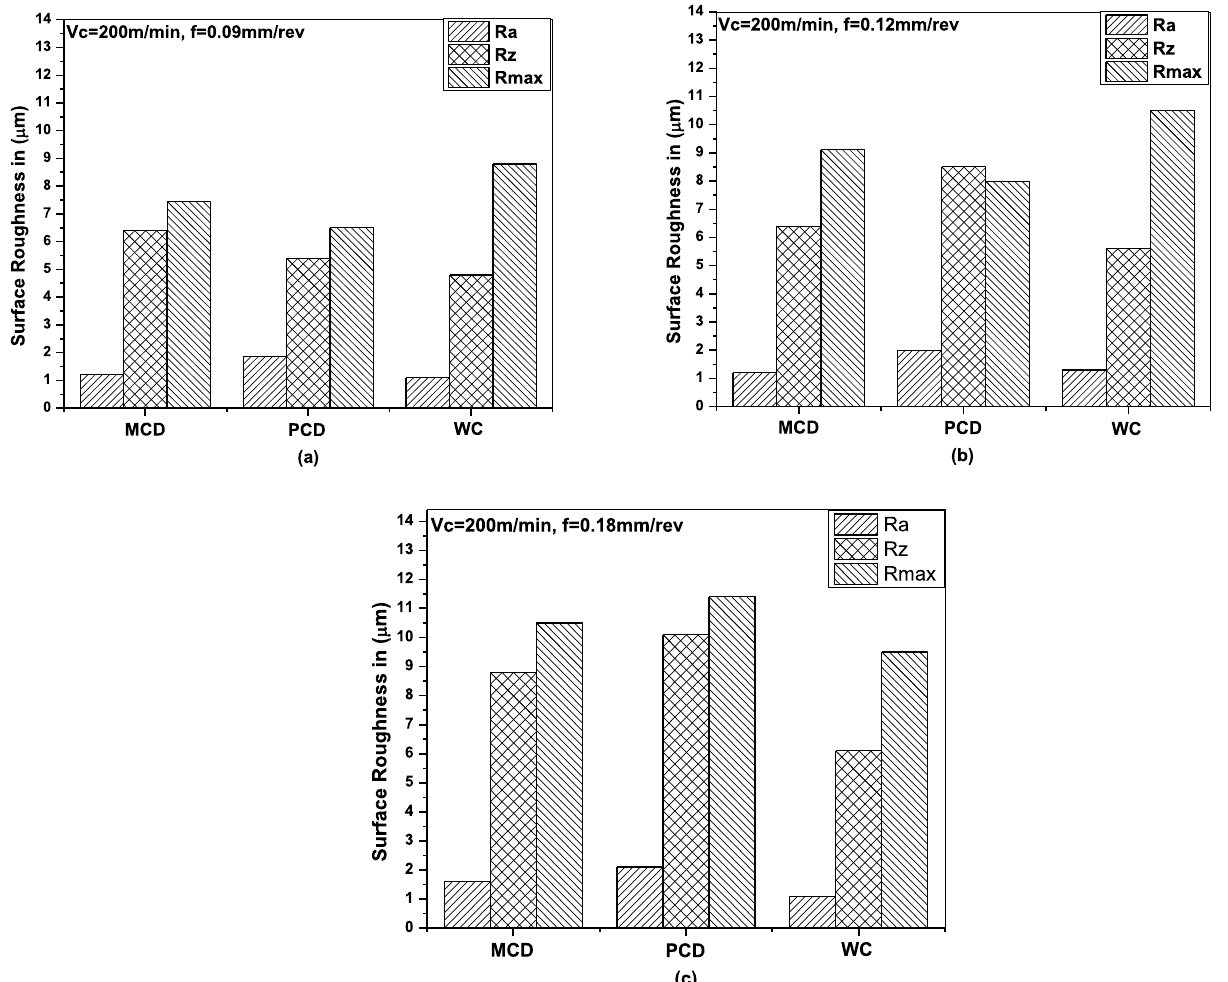
Fig. 16. Graph representing the roughness values ( Ra , Rz , R max ) for different tools at constant velocity of 200 m/min and varying feed, (a) Feed = 0.09mm/rev, (b) Feed =0.12 mm/rev and (c) Feed =0.18 mm/rev; constant depth of cut